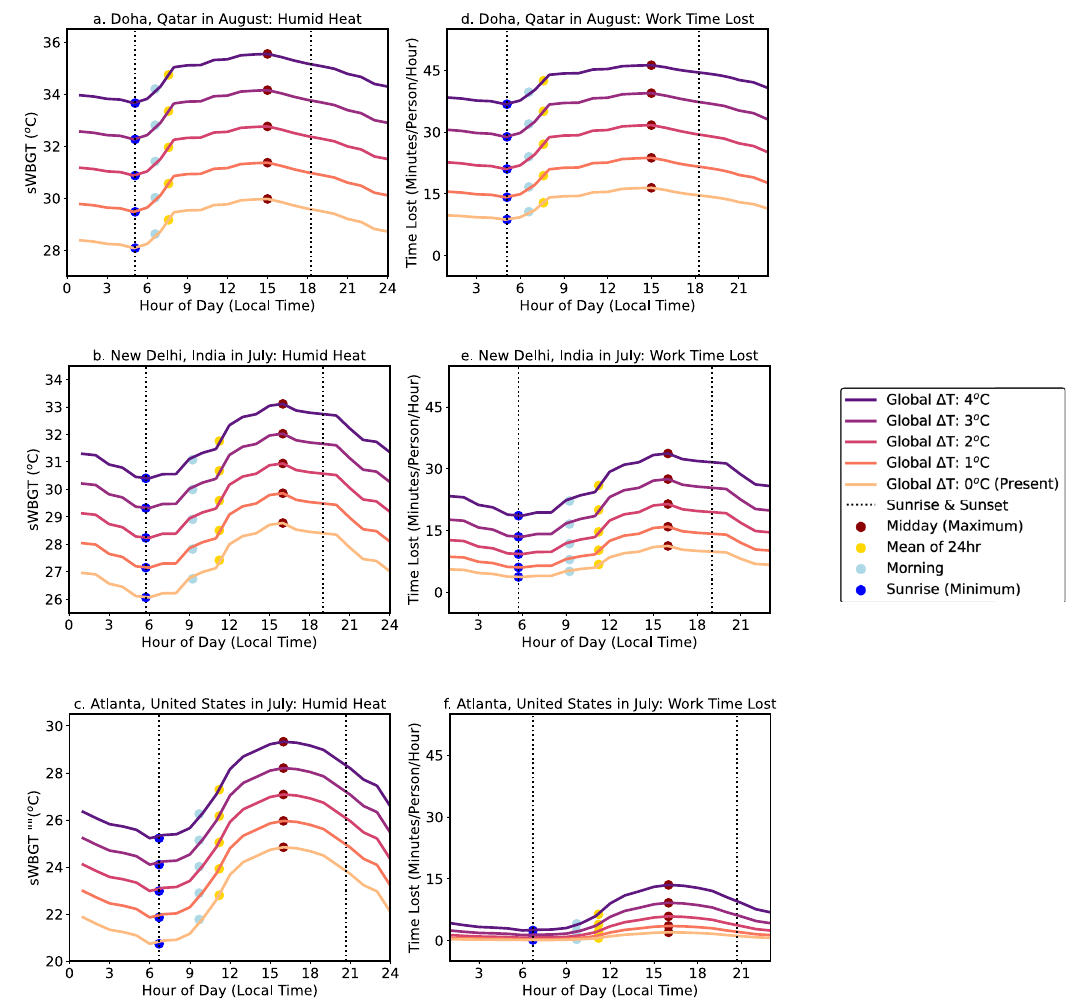
Fig. 1 Diurnal cycles of heat exposure and labor productivity losses. Climatological average (2001-2020) diurnal cycles of simpli fi ed Wet Bulb Globe Temperatures (sWBGT, a – c ) and heavy labor lost ( d – f ) for Doha, Qatar in August ( a , d ), New Delhi, India in July ( b , e ), and Atlanta, United States in July ( c , f ). The diurnal cycle is calculated from 2-m air temperature, surface pressure, and 2-m dew point temperature from hourly European Centre for Medium-Range Weather Forecast 5th Generation Reanalysis (ERA5) data. The bottom line shows the 2001 – 2020 mean, and the darker colored lines show sWBGT and labor losses for global-mean temperature changes (Global Δ T ) of + 1 °C, + 2 °C, + 3 °C, + 4 °C relative to the recent past. Local warming magnitudes are derived from Coupled Modeling Intercomparison Project, Phase 6 (CMIP6) warming projections ( “ Methods ” ). The reanalysis-derived climatological averages of sWBGT shown here are intended for illustrative purposes; hourly temperatures on a speci fi c day can be higher than the 20-year mean diurnal cycles for these months.